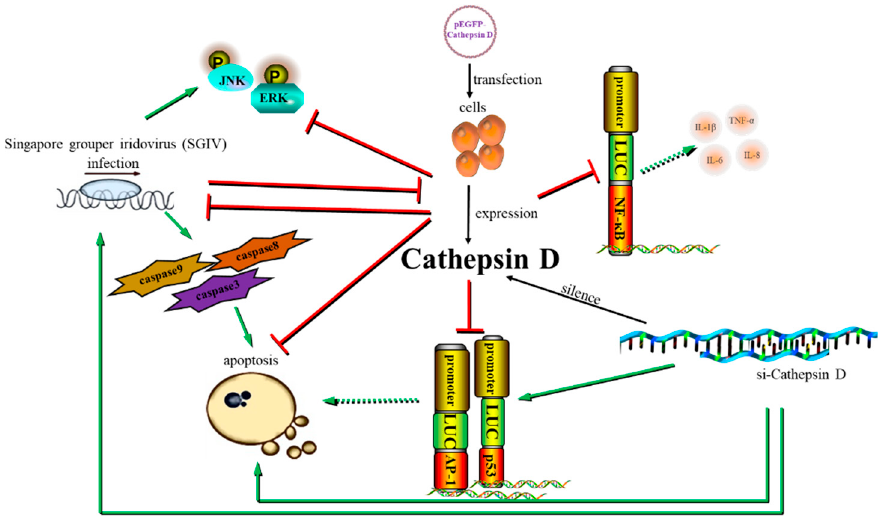
Figure 8. Schematic diagram of the regulation of Ec-CD during SGIV infection.